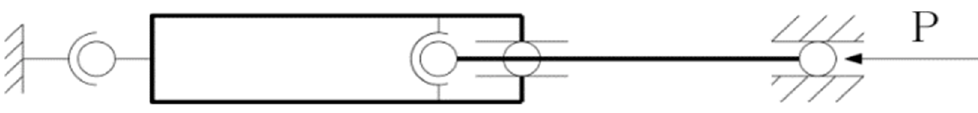
Figure 6. Buckling FE model.